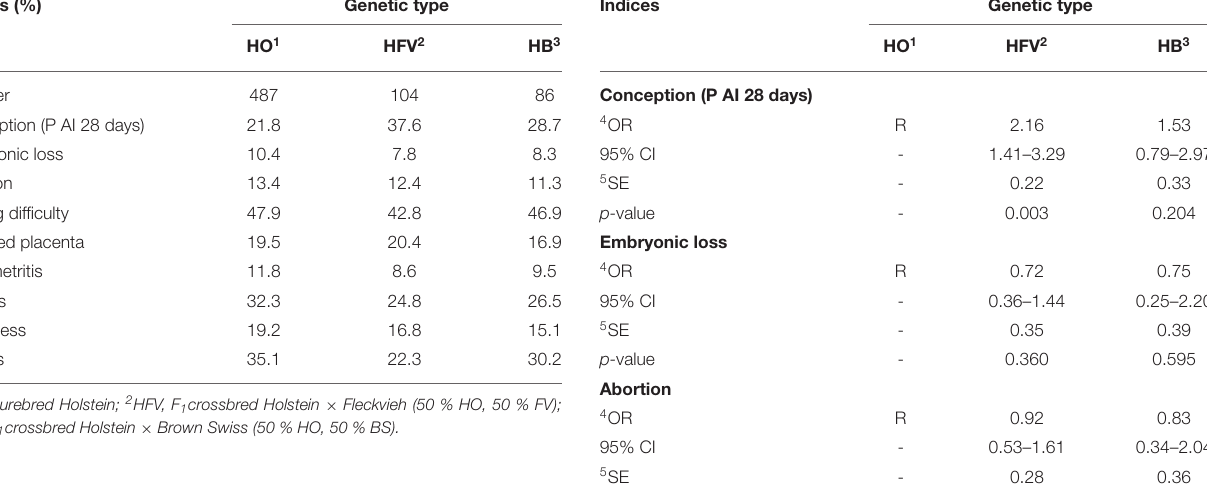
TABLE 3 | Odds ratio for reproductive indices of purebred Holstein, Holstein × Fleckvieh, and Holstein × Brown Swiss cows. Indices Genetic